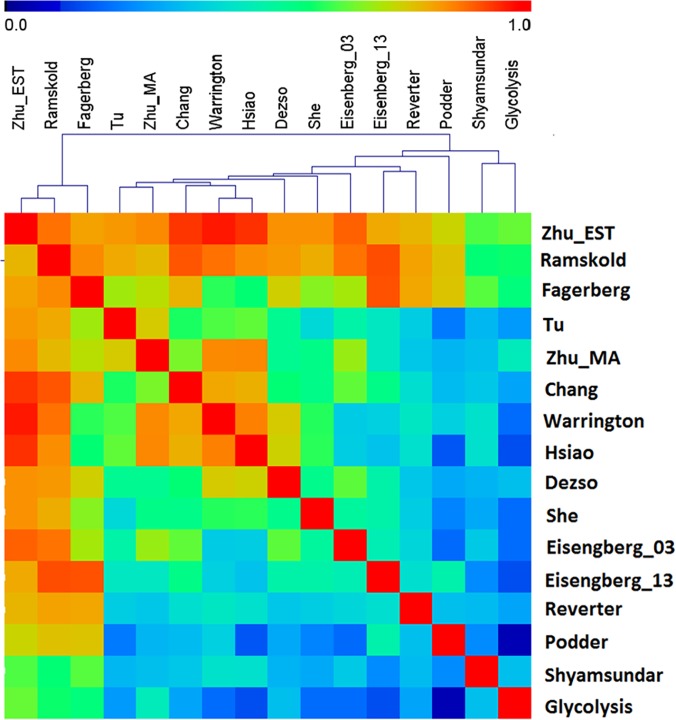
Pairwise comparison of all HK-gene lists.The color represents the similarity ratio, i.e. the ratio of the number of common genes to number of genes in the smaller list. Blue color represents a ratio of 0, and red represents 1.0.